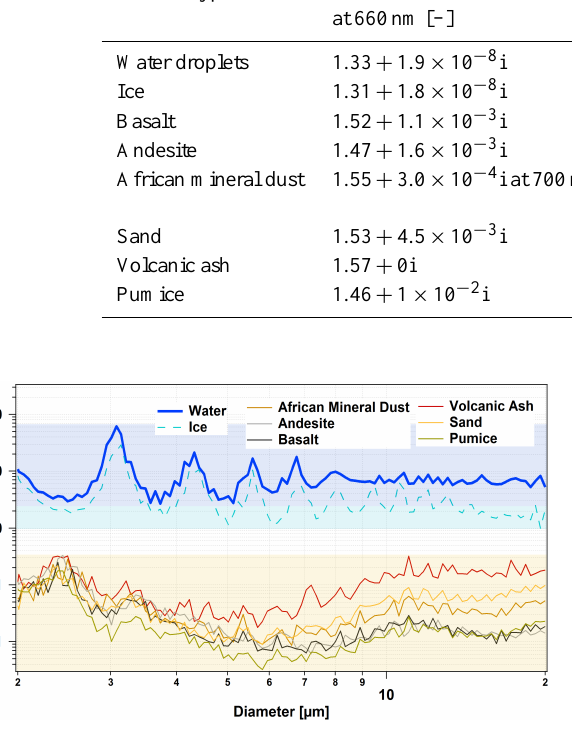
Figure 2. The theoretical R values at λ 1 = 660nm and λ 2 = 2750nm as a function of the particle diameter for different types of